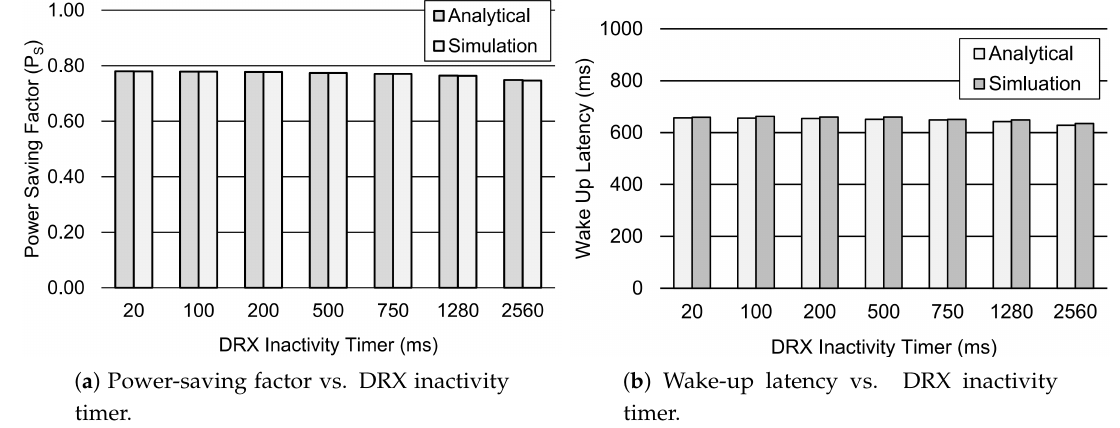
Figure 5. Performance analysis of the DRX mechanism for different values of T I . Other parameter = 60 s, T = 40 ms, T = 0.64 s, T = 1.28 s, T = 260 ms, and T settings are 1 ON SC LC RC λ